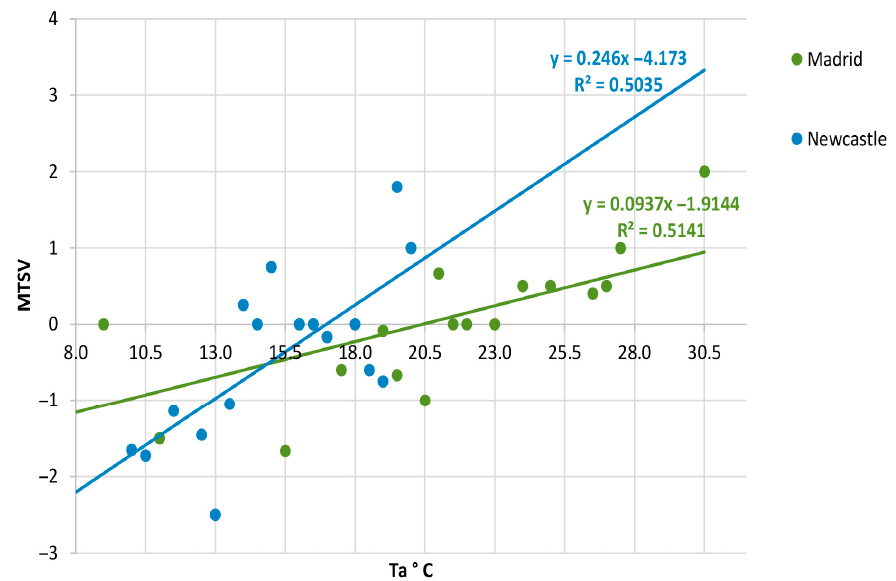
Figure 7. Linear regression air temperature vs. mean thermal sensation votes (MTSV) for Madrid and Newcastle.